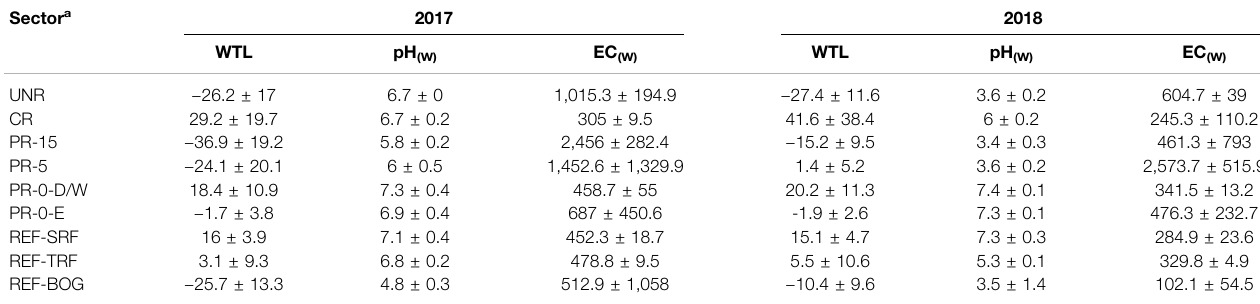
TABLE 2 | Mean ± SD water table level (in cm), pH and electric conductivity (EC in µS cm − 1 ) in all different restoration sectors a on two well pads PRIV and CLAK and three reference ecosystems. Negative values signify a water table below the soil surface, and positive values signify a water table above the soil surface. Sector